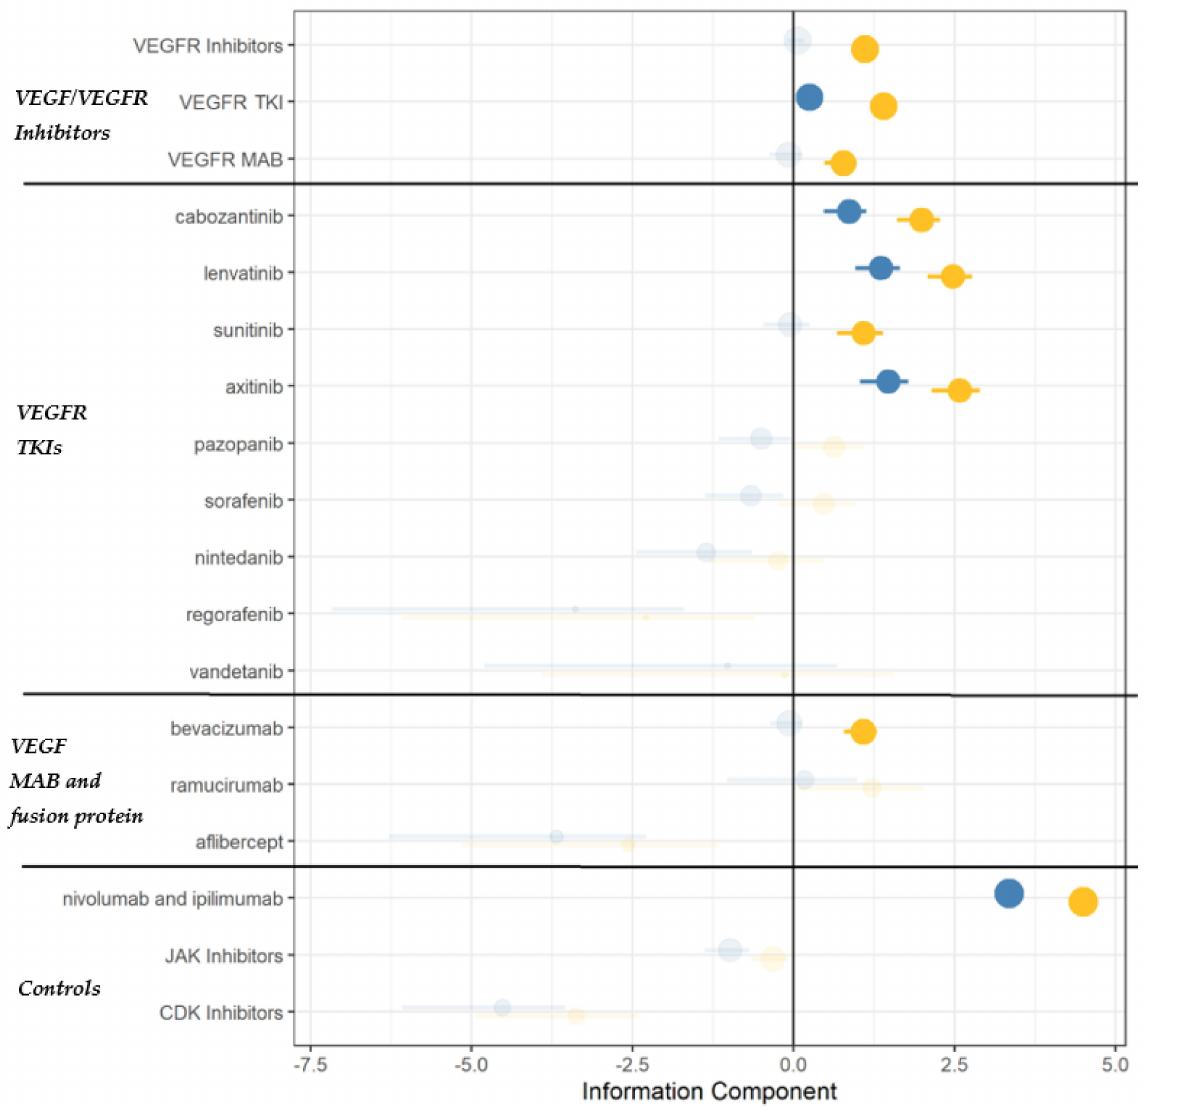
Figure 2. Disproportionality analysis through the Information Component (IC). Yellow and blue dots represent IC estimates that were calculated using all drugs in the database, and anticancer drugs as a comparator, respectively. Estimates are proportional to the number of cases. VEGFR: vascular endothelial growth factor receptor; TKI: tyrosine kinase inhibitors; MAB: monoclonal